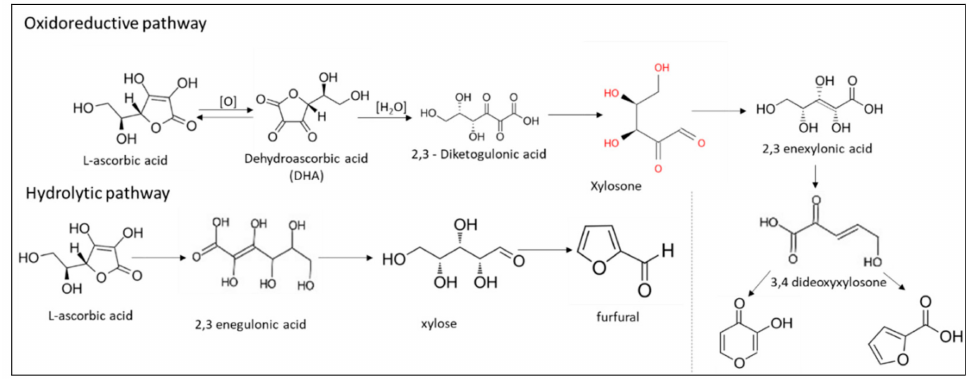
Figure 2. Alternative degradation mechanisms of L-ascorbic acid